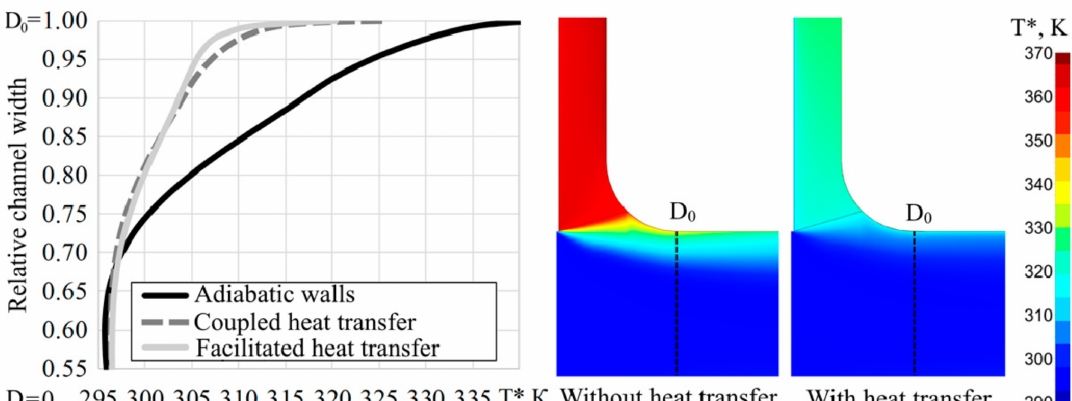
Figure 4. Temperature profiles at the inlet to the impeller for three variants of flow part heat exchange.